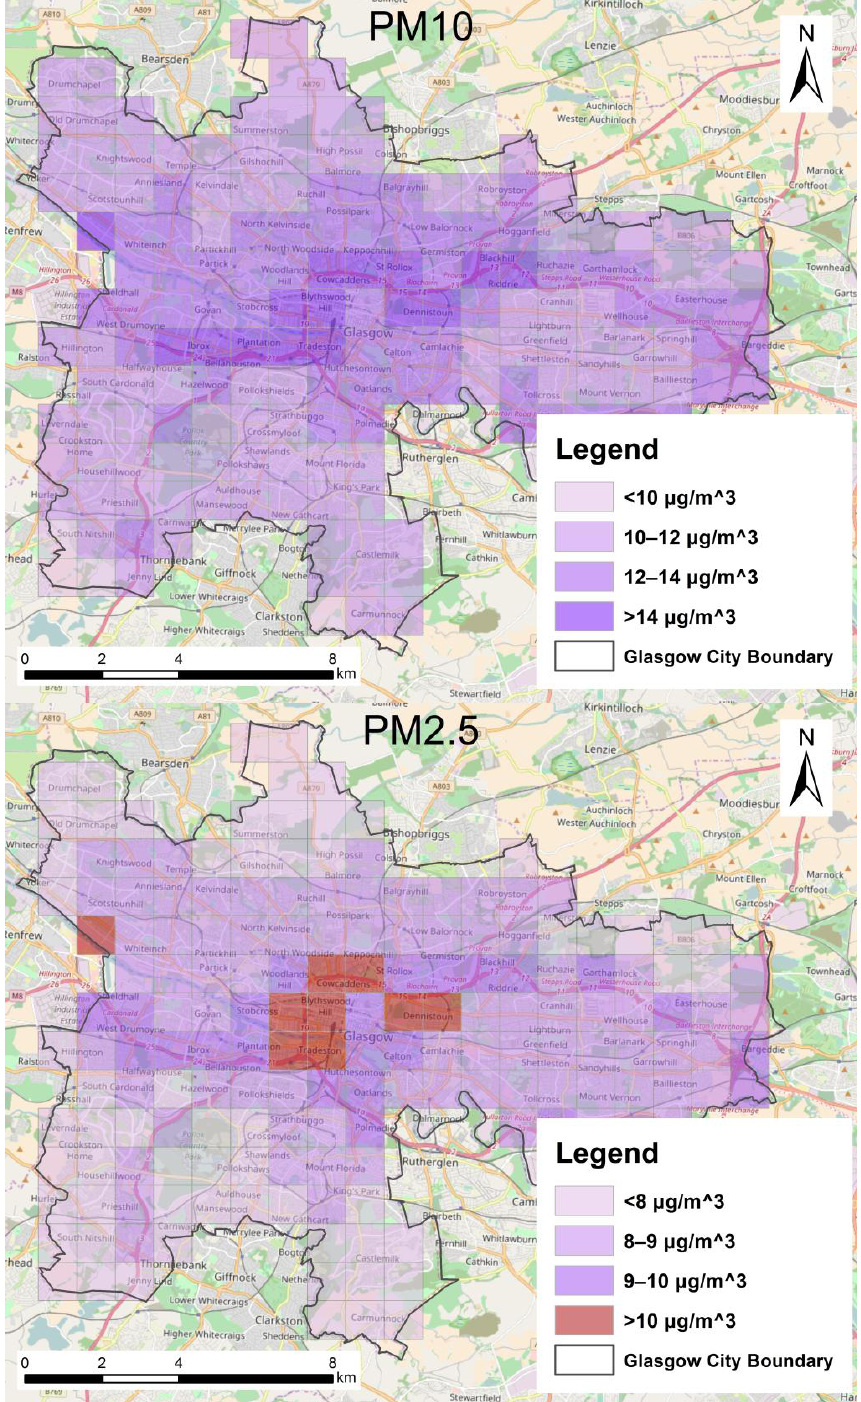
Figure 4. PM grids in Glasgow to represent levels of PM 10 and PM 2.5 (source: Scottish Air Quality Database, SAQD).